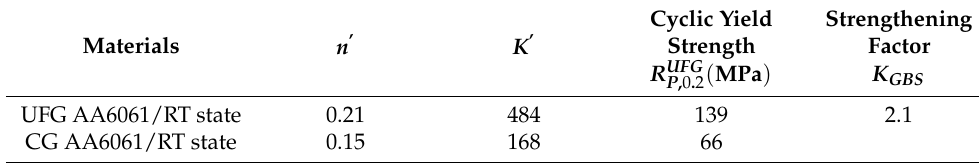
Table 3. Characteristic parameters of UFG AA6061 and CG AA6061.